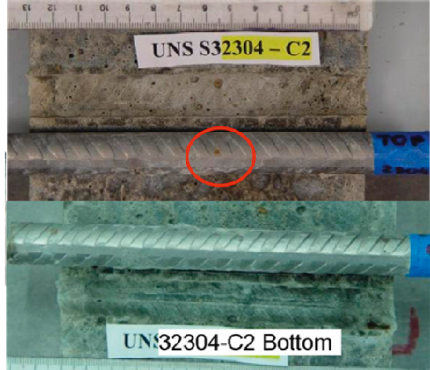
Figure 4: Corrosion spot on the top side of rebar embedded in mortar specimens S32304-C2.